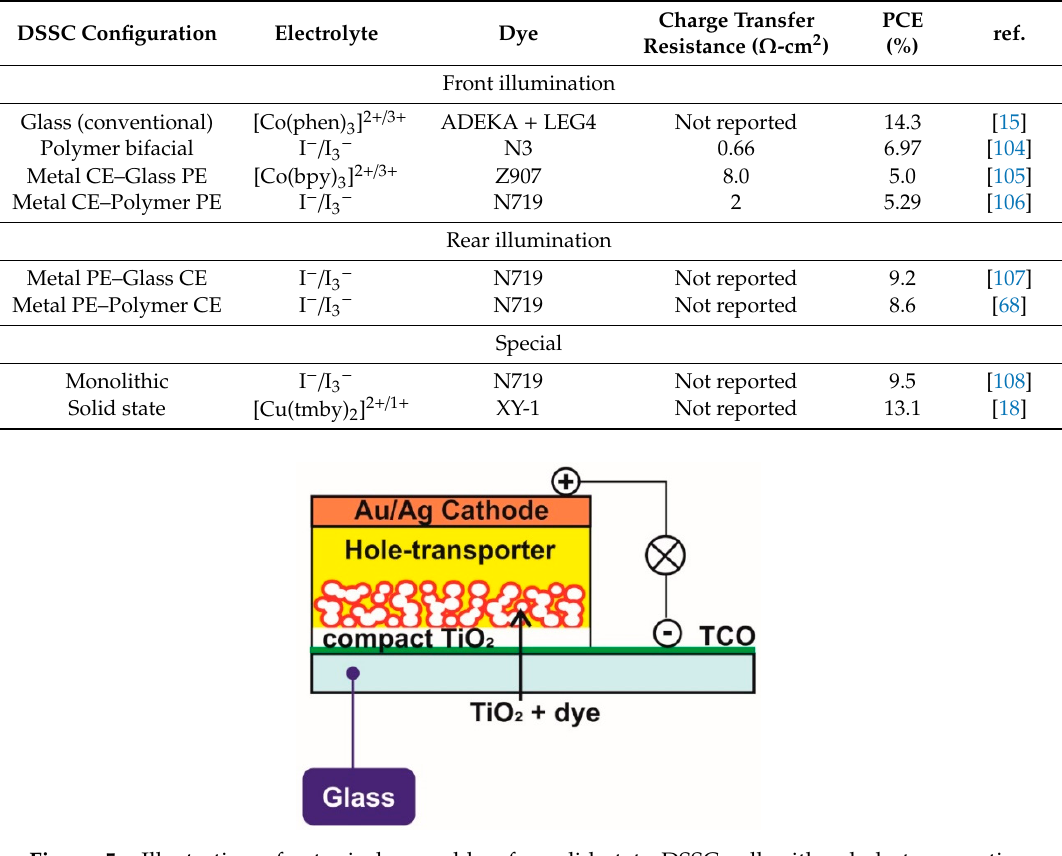
Figure 5. Illustration of a typical assembly of a solid state DSSC cell with a hole transporting material [97].